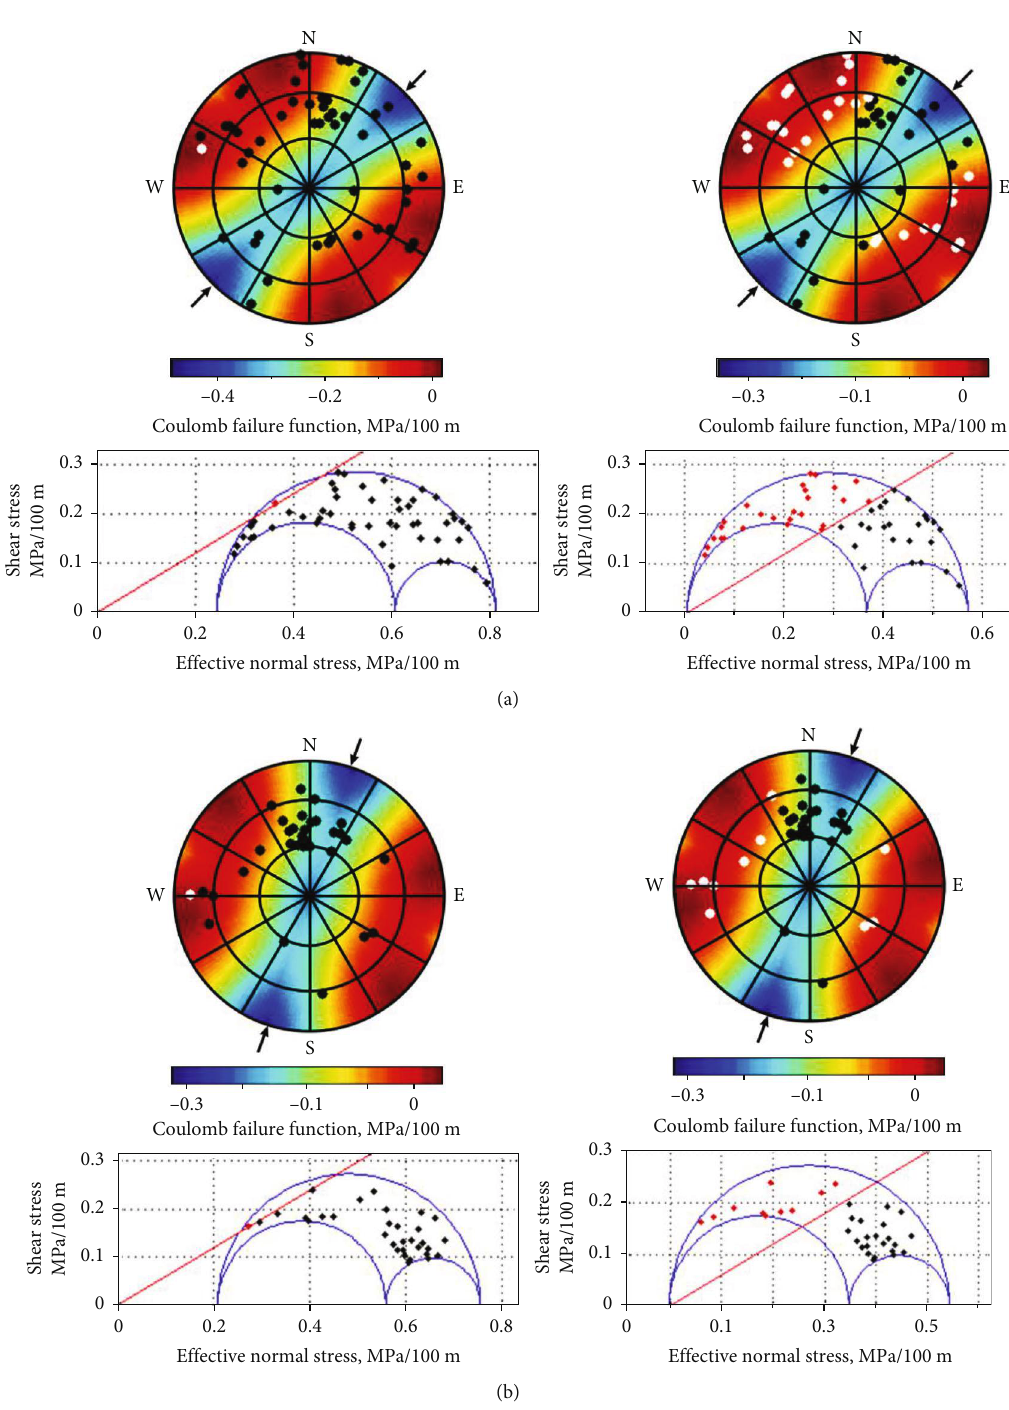
Figure 13: Fracture opening rate simulation results in the Dibei gas